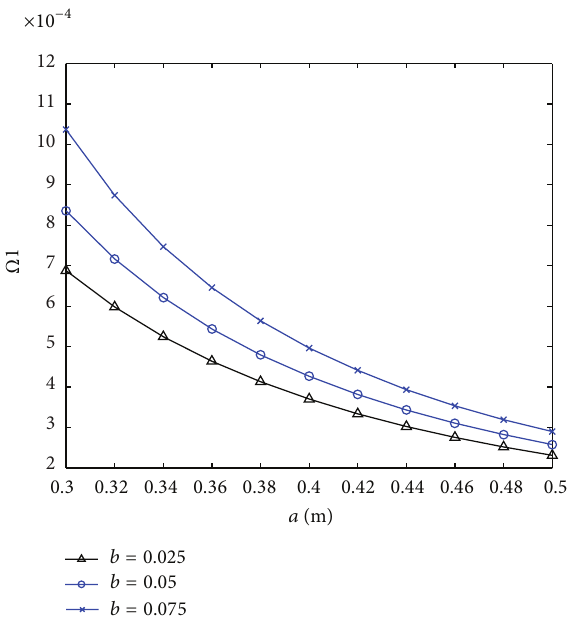
Figure 4: Variation of the first mode natural frequency with the radius of the plate for different hole radiuses and clamped-clamped boundary conditions ( ℎ 𝑐 = 1 mm).